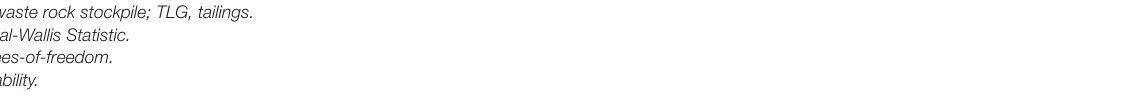
TABLE 4 | Summary of ANOVA of growth, nodulation, and mycorrhization characteristics of umbrella thorn and cowpea plants that were grown in greenhouses on different soils from mining sites.